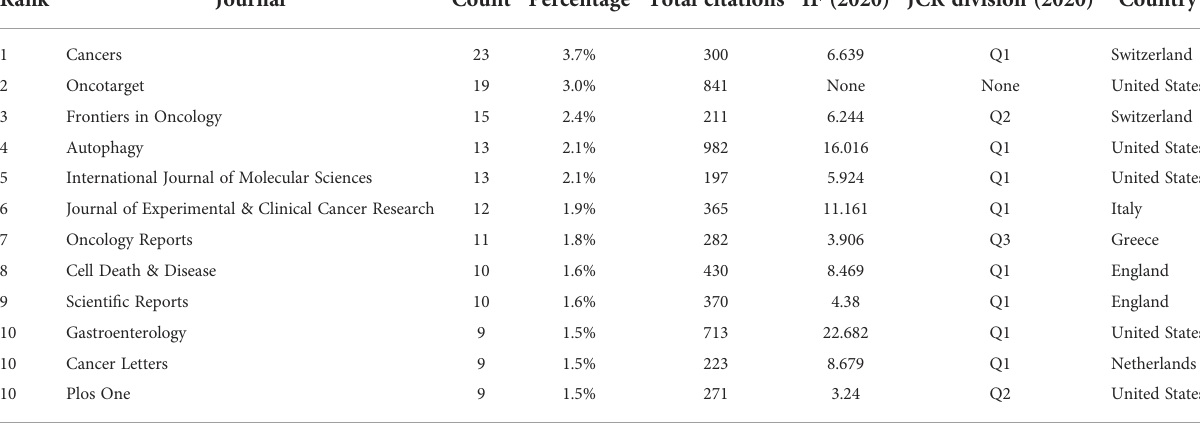
TABLE 3 The top 12 productive journals associated with autophagy of pancreatic cancer.